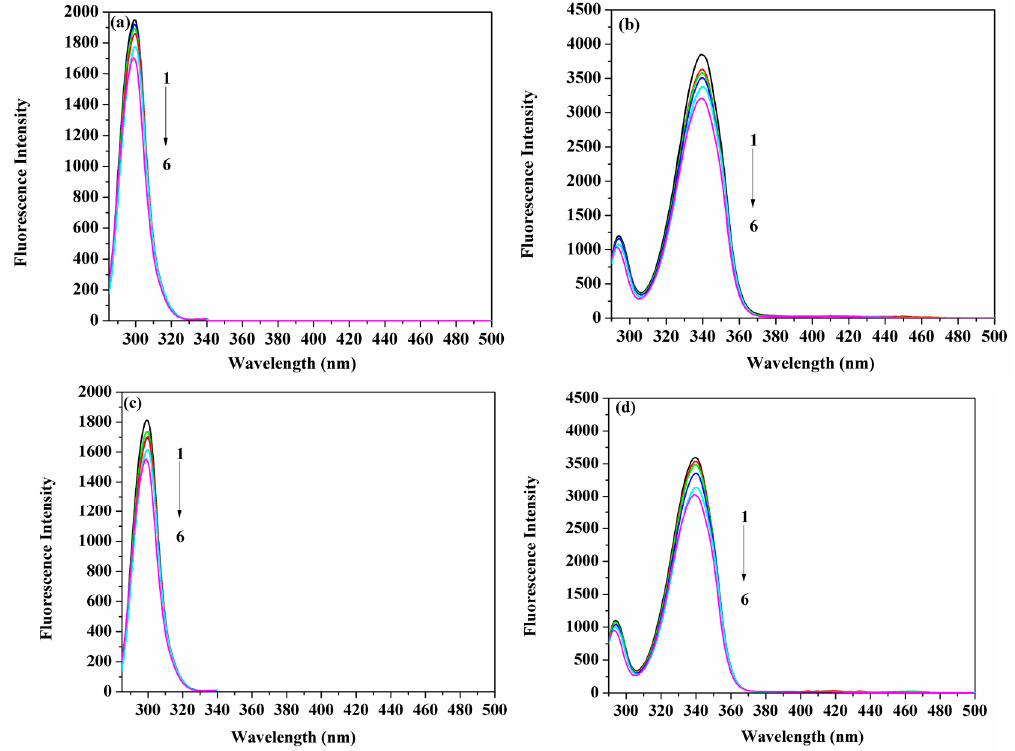
Figure 7. Spectra of the synchronous fluorescence of HSA (1.5 µ M) with the addition of ACV (1–6 represent 0, 3.5, 7, 15, 25 and 35 µ M, respectively) at ∆ λ = 15 nm ( a ) ∆ λ = 60 nm ( b ) and the addition of PNV (1–6 represent 0, 3.5, 8.0, 17, 28 and 35 µ M, respectively) at ∆ λ = 15 nm ( c ) ∆ λ = 60 nm ( d ).